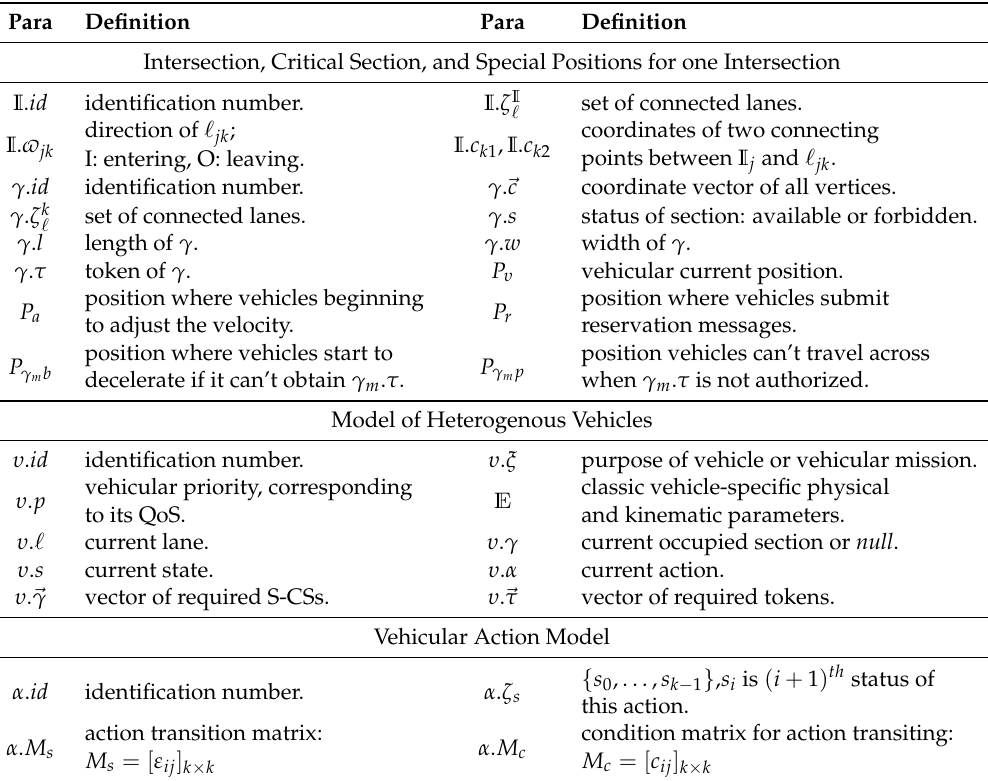
Table 1. Definitions and Parameters of Traffic